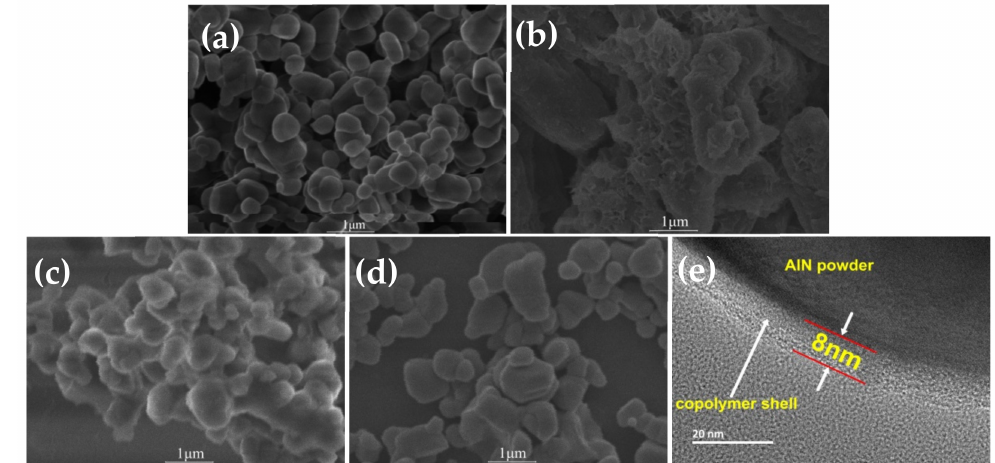
Figure 7. SEM topography of AlN powder: ( a ) Original AlN powder; ( b ) hydrolyzed AlN powder; ( c ) block copoly- mer modified AlN powder; ( d ) AlN powder modified by micro-crosslinking; ( e ) TEM topography of AlN powder modified by